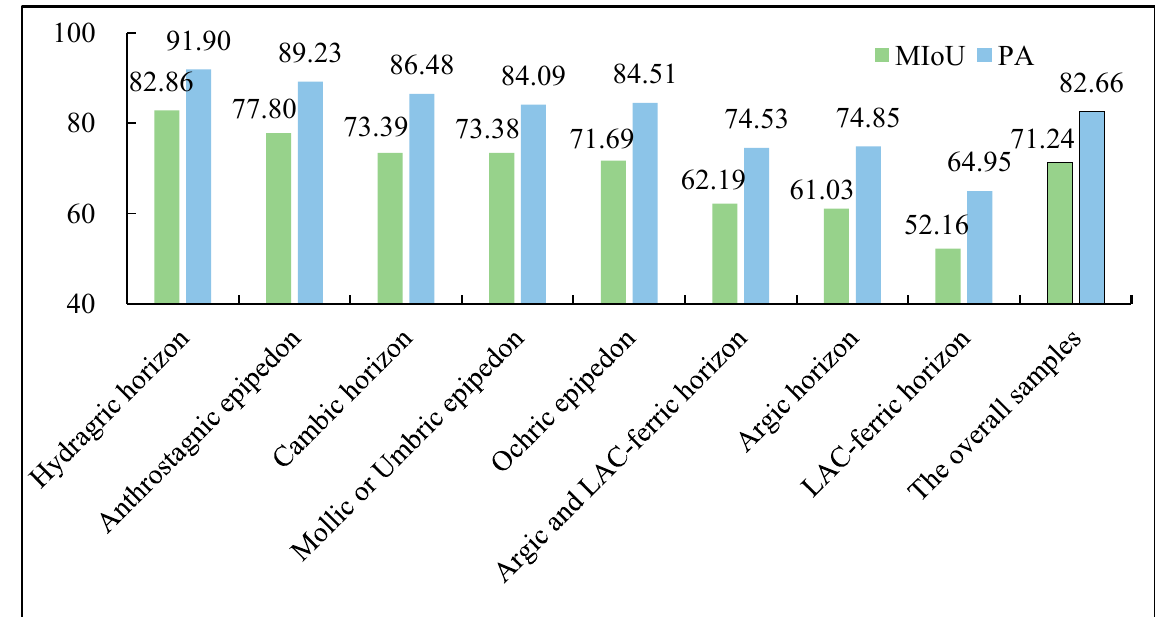
Figure 12. Identification capability of each diagnostic horizon of the final model (Table 4).